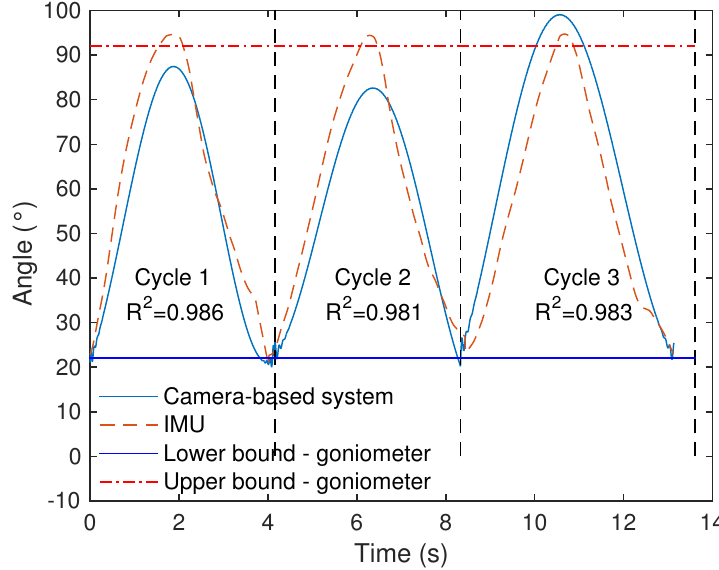
Figure 8. Camera-based system and IMU angles of the first test.